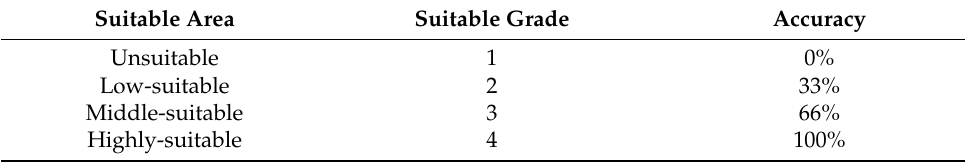
Table 2. Comparison table of accuracy and suitable